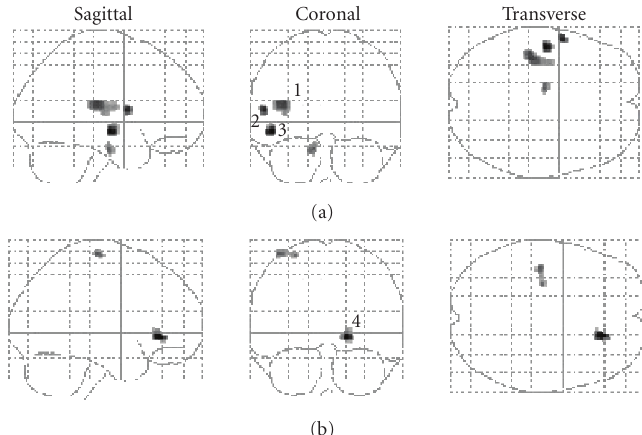
Figure 3: Statistical parametric maps displaying significant di ff erences in gray matter volume of PD patients ( n = 19) relative to healthy controls ( n = 20). (a) Increased gray matter volume, (b) decreased gray matter volume. 1 = left insula; 2 = left superior temporal gyrus; 3 = midbrain; 4 = right anterior